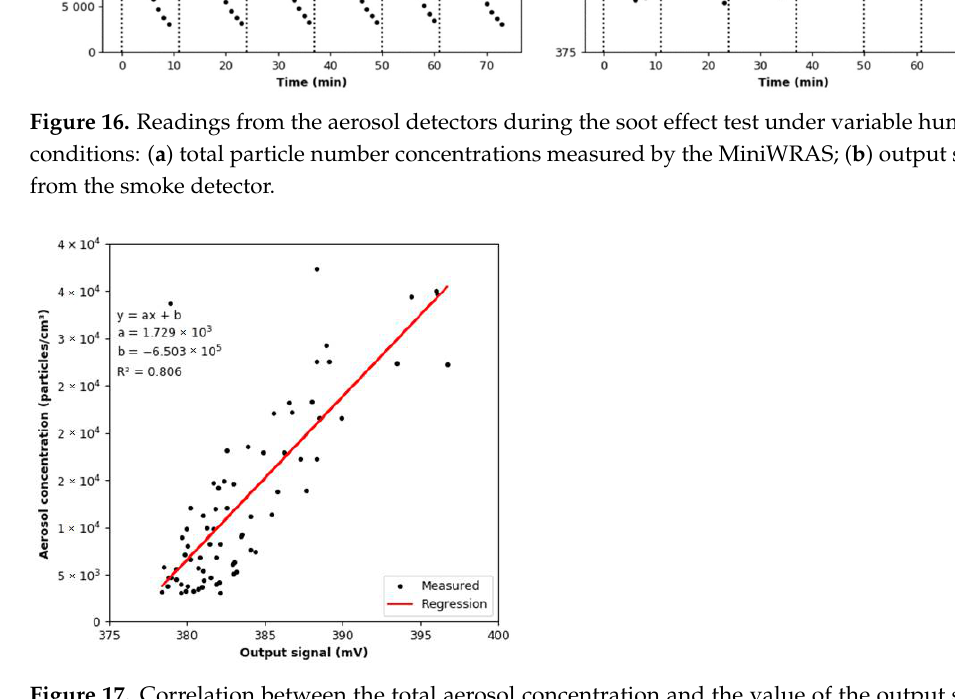
Figure 17. Correlation between the total aerosol concentration and the value of the output signal from the smoke detector under variable humidity conditions.